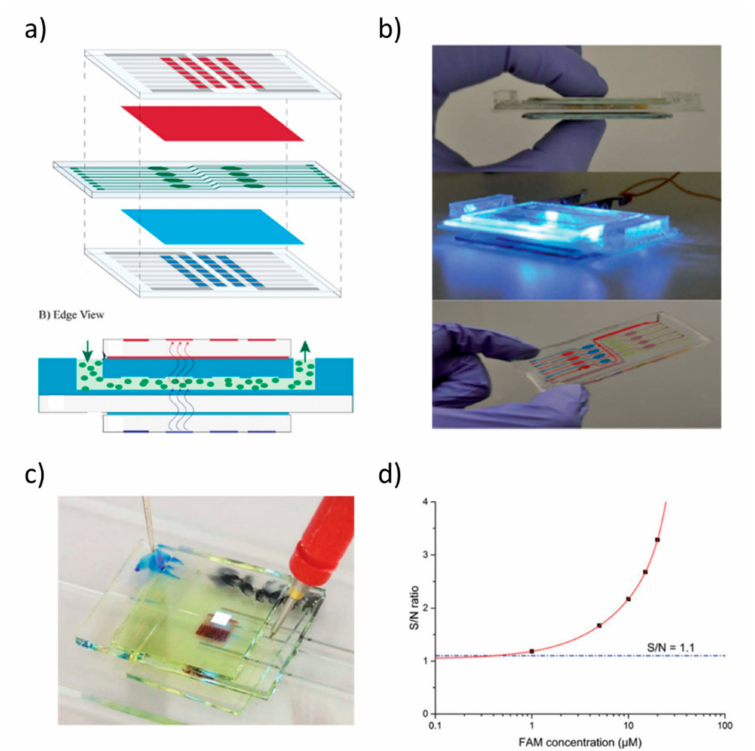
Figure 10. Schematic representation ( a ) and picture ( b ) of the algal fluorescence sensor based on a microfluidic chip comprising: (i) OLED, (ii) OPD, (iii) emission filter and (iv) excitation filter, adapted from Ref. [158] with permission from The Royal Society of Chemistry, © 2020. On-chip fluorescence sensor based on OLED and OPD ( c ) and the corresponding response to increasing concentration of fluorescein amidite ( d ), reproduced with permission from Ref [159], © 2020 The Royal Society of